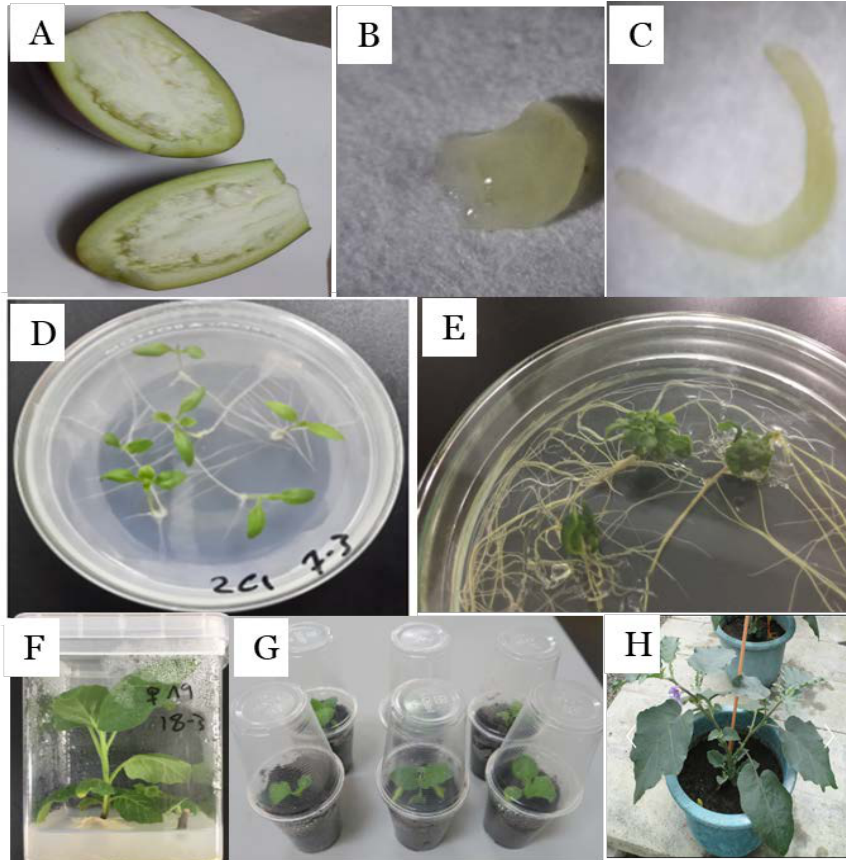
Figure 2. Embryo rescue technique used: ( A ) immature fruit come from crosses between S. melongena and S. incanum ; ( B ); heart embryo stage; ( C ) torpedo embryo stage; ( D ) plantlets germinated directly from an embryo; ( E ) abnormal plantlets; ( F ) normal plant grown in a jar; ( G ) acclimatized plants; and ( H ) mature acclimatized hybrid plant grown in a greenhouse. The diameter of the Petri dishes in D and E is 9 cm. The flask in F has a diameter of 6.5 cm and a height of 9.8 cm. The glasses in G have a mouth diameter of 5.8 cm and a capacity of 100 cm 3 . The pot in H has a mouth diameter of 30 cm and a capacity of 5 Table 2. Effect of tissue culture media on germination (%) of different embryo stages and abnormal plants of the reciprocal hybrids between S. melongena EG203 and S. incanum UPV1. The number of embryos used for each embryo stage and medium is indicated (N).